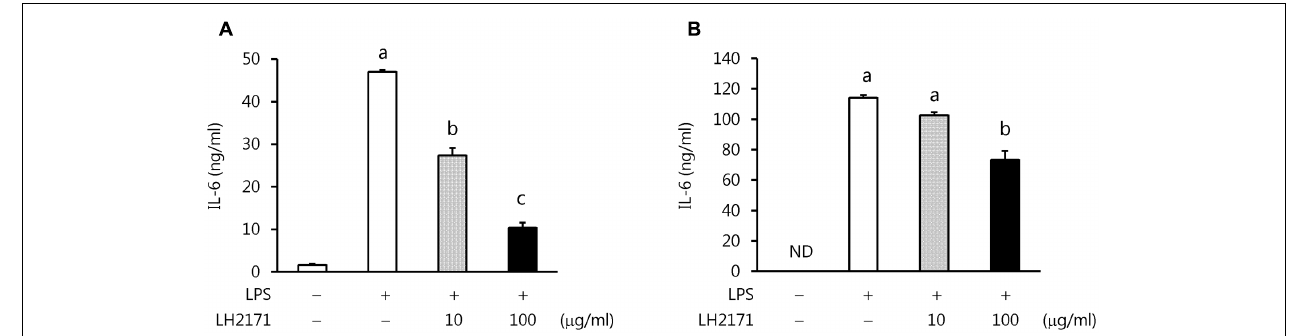
FIGURE 6 | Inhibition of IL-6 production from LPS-stimulated DC2.4 and RAW264.7 cells by LH2171. DC2.4 cells (A) or RAW 264.7 cells (B) were incubated with or without LH2171 for 4 h, and then stimulated with LPS for 20 h. The amount of IL-6 produced was measured in the culture supernatants by enzyme-linked immunosorbent assay. Data are shown as means ± SEM ( n = 3). Statistical differences between the groups were analyzed using the Tukey–Kramer test and significant differences ( P < 0.05) are represented by different letters (a–c).